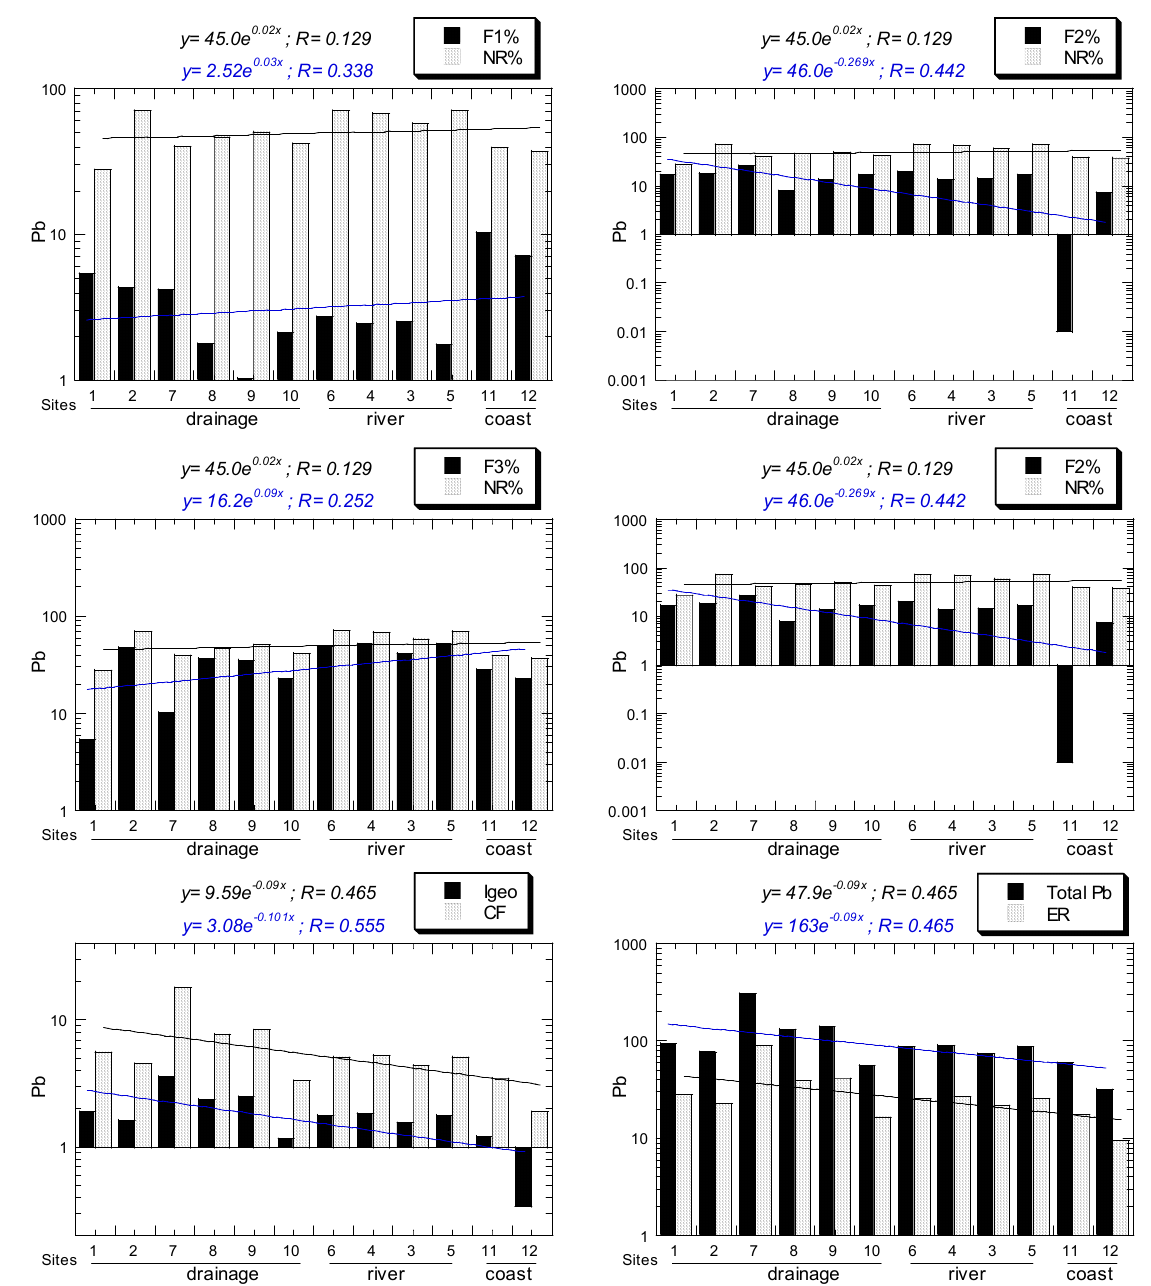
For Pb, all I geo values of all sites ranged from 0.34, "practically unpolluted", to 3.59, "strongly polluted". For Pb, all CF values of all sites ranged from 1.90, "moderate", to 18.1, "very high". For Pb, all ER values of all sites ranged from 9.47, "low potential ecological risk", to 90.3, "considerable potential ecological risk". All the above Pb values decreased from the drainage to river and coastal sediments (Figure 5).